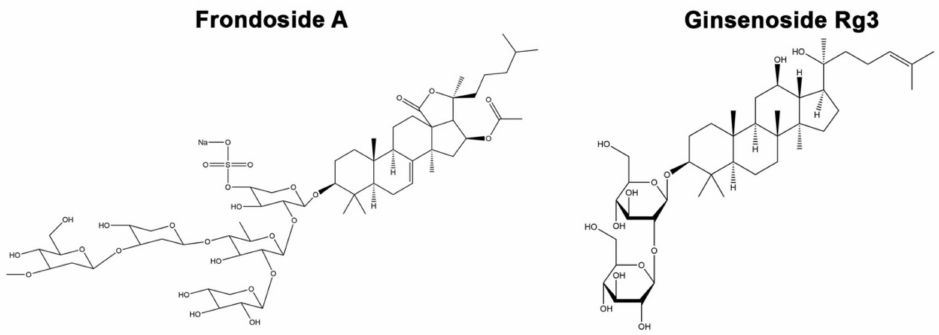
Figure 1. Structure of frondoside A (FA) and ginsenoside Rg3 (Rg3). (Drawn by Chemdraw). Natural saponins can also be found in marine invertebrates. Frondoside A